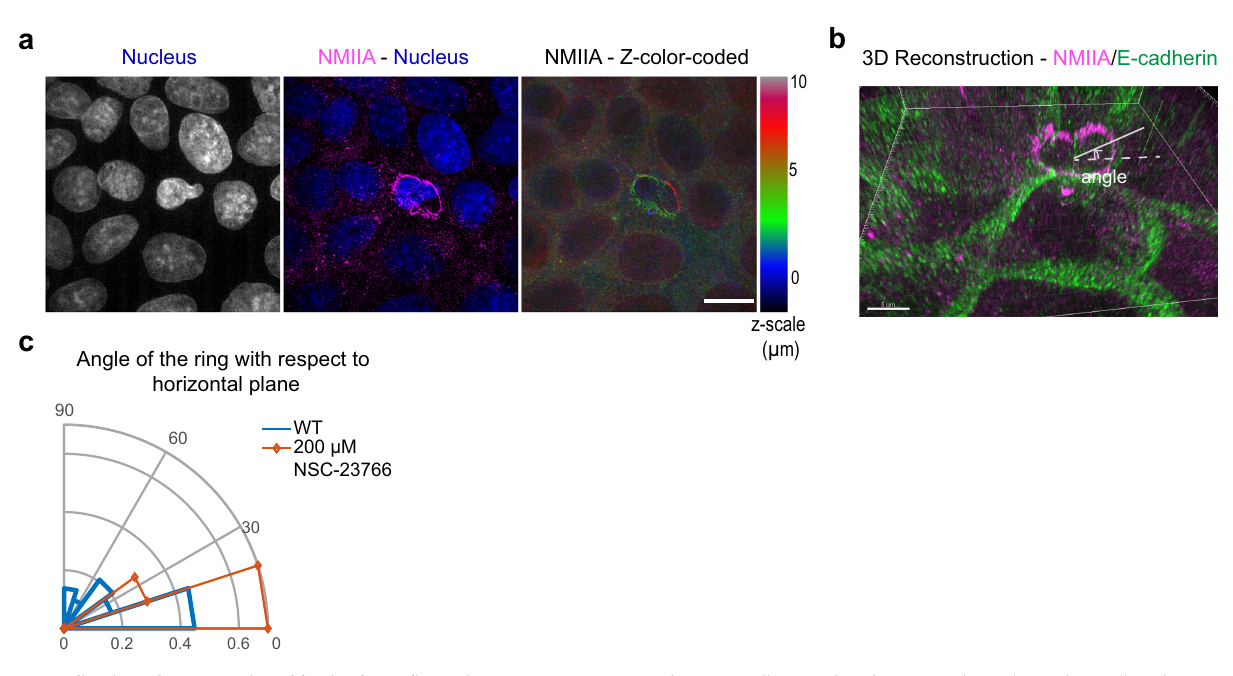
Fig. 3 Localization of actomyosin cables in three-dimension. a Immunostaining of MDCK cells extruding from monolayer (extruding cell at the center), DAPI channel, Merged of DAPI and AlexaFluor-568 channel, Myosin staining color-coded according to the height of the monolayer. The contrasting localization of myosin around nucleus at two separated planes (~3 µ m versus 7 µ m at each side) suggested the partitioning of the purse-string into two rings which are tilted. Differential localization of actomyosin cables were observed in 34 extrusion events from 4 independent experiments. b 3D reconstruction for images in a . A circular fi t was performed on each ring on 3D reconstruction images. The angle at which the circle formed with horizontal plane xy was de fi ned as shown on the image. c Histogram of distribution of angles that the purse-string ring forms w.r.t horizontal plane. (WT: n = 32 rings in m = 19 extrusion events; NSC-23766 (Rac-inhibitor): n = 10 rings in m = 11 extrusion events). Source data are provided as a Source Data fi